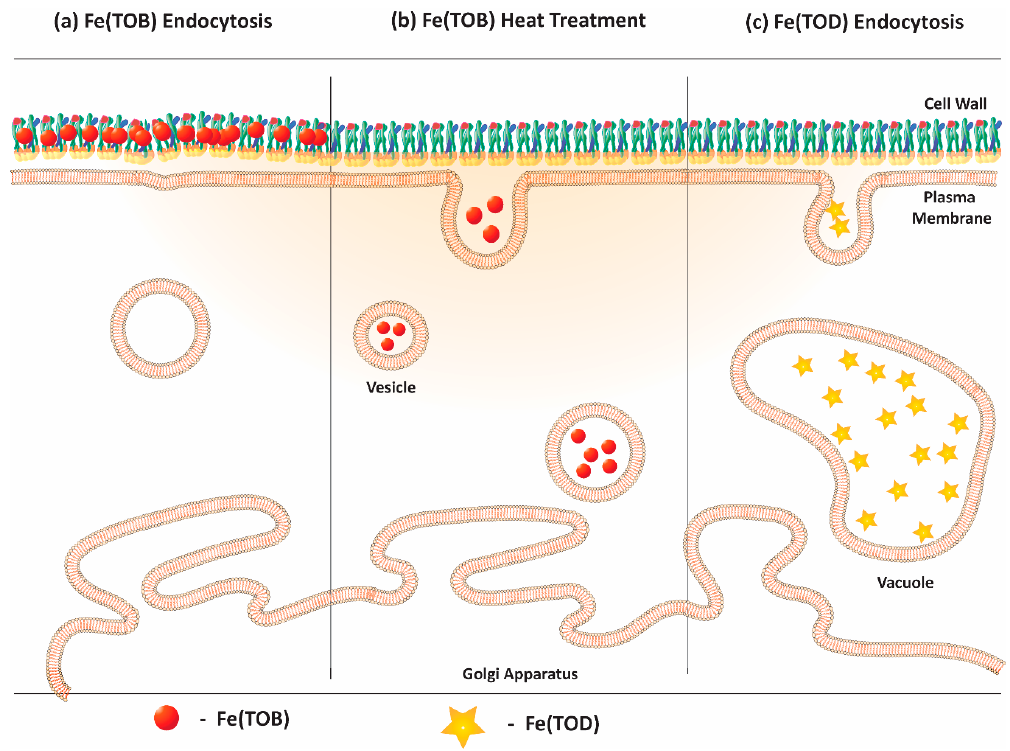
Figure 7. Schematic representation of the uptake and cell association with the tentative localization of Fe(III) complexes: ( a ) endocytosis treatment of Fe(TOB), ( b ) heat treatment of Fe(TOB), and ( c ) endocytosis treatment of Fe(TOD).